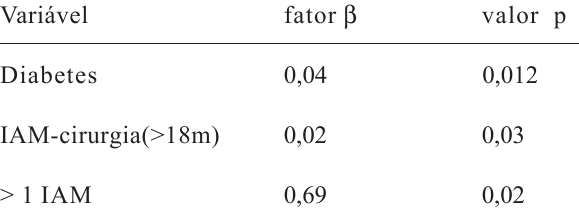
Tabela 3. Fatores relacionados com